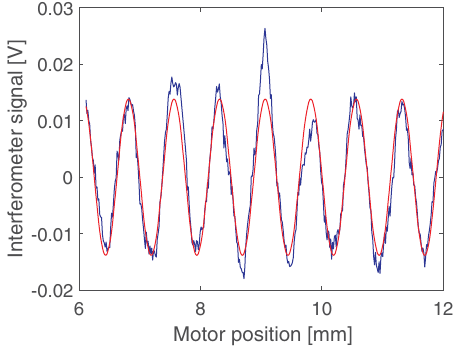
FIG. 22. Example of a frequency measurement carried out with the interferometer, where the blue curve is the interferometer pyrodetector signal as a function of the motor position, and the red curve is a sinusoidal